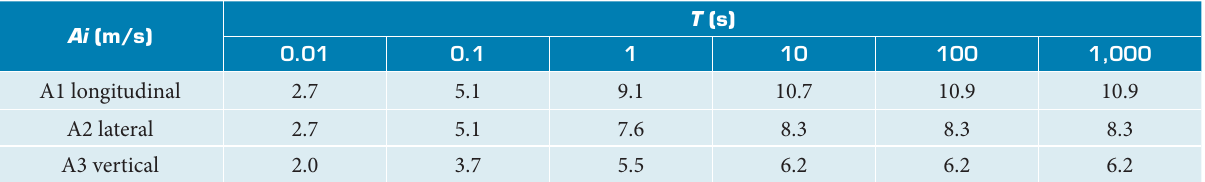
Table 5. Approximate discrete gust amplitudes ( Ai ) versus gust duration time ( T ) for use in Shuttle on-pad studies. These values are used in Eq. 5 to compute the discrete wind gust speed.